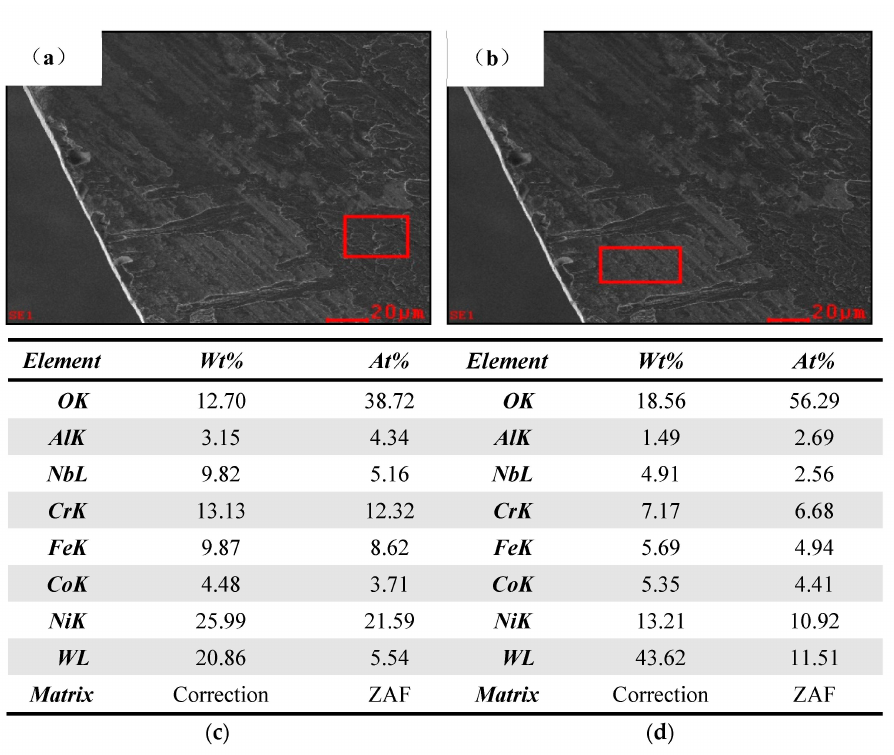
Figure 12. Adhesive wear EDS on the front edge of coated drill. ( a ) Bonded area on the front surface of the CrAlYN coated bit. ( b ) Coating falling off area on the front surface of the CrAlYN coated bit. ( c ) Element composition list in the figure. ( d ) Element composition list in the figure.